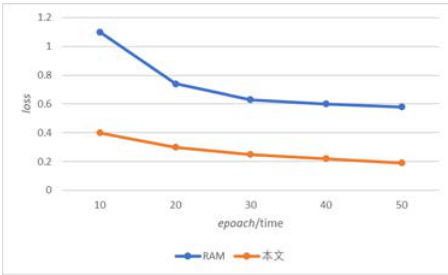
Fig. 2. Loss function value change curve.